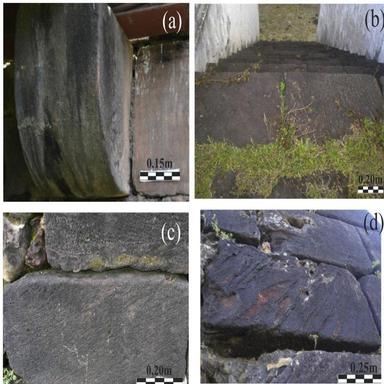
Several other FSS applications in FSJM: (a) drawbridge console; (b) staircase steps; (c, d) examples of FSS stonework blocks in corners where the characteristic color and cross-stratification are very evident.